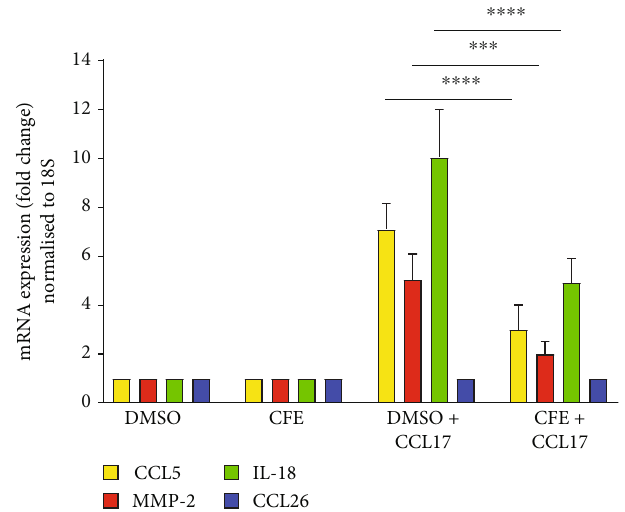
Figure 6: E ff ect of the pure corn fl ower extract (CFE, 1 mg/mL) on CCL5, MMP-2, and IL-8 expression after in fl ammation induction by CCL17. Relative gene expression was calculated using the delta CT method after normalization to ribosomal 18S expression. Experiment was performed in triplicate. One-way ANOVA: ∗∗∗∗ p < 0 : 0001 ; ∗∗∗ p < 0 : 005 .